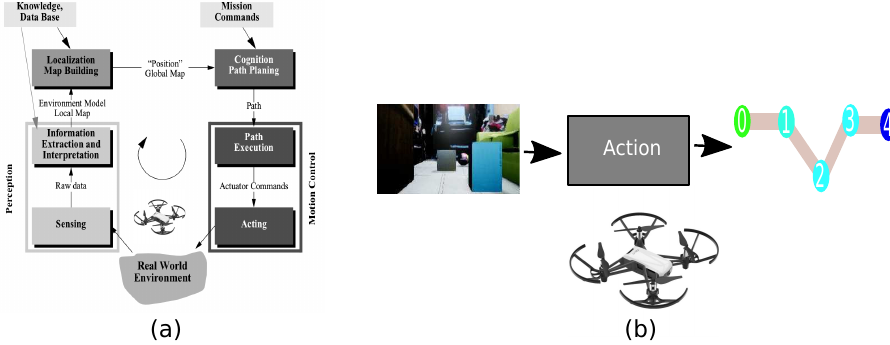
Figure 1. Path planning architecture. ( a ) Standard architecture. ( b ) Reduced